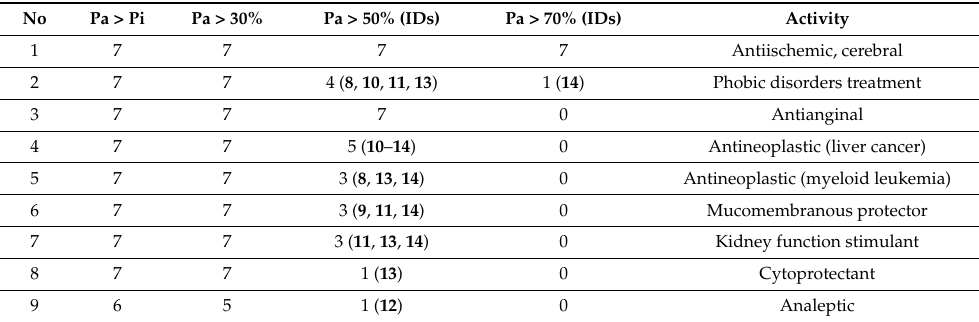
Table 3. The number of compounds with a prediction of the most frequent and likely pharmacologi- cal